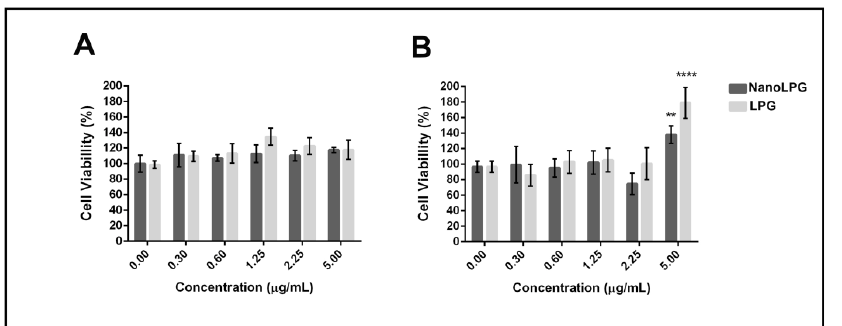
Figure 2. Cytotoxicity of free LPG and nanoLPG after 24 h. ( A ) HaCaT and ( B ) L929 (NCTC) cell viability. Bars represent cell viability, measured by the PrestoBlue assay (ThermoFisher), in percentage after treatments at the indicated concentrations. The data represent the mean ± SD of one independent experiment in quintuplicate. ** p < 0.01 and **** p < 0.0001. Treatment compared to untreated control.